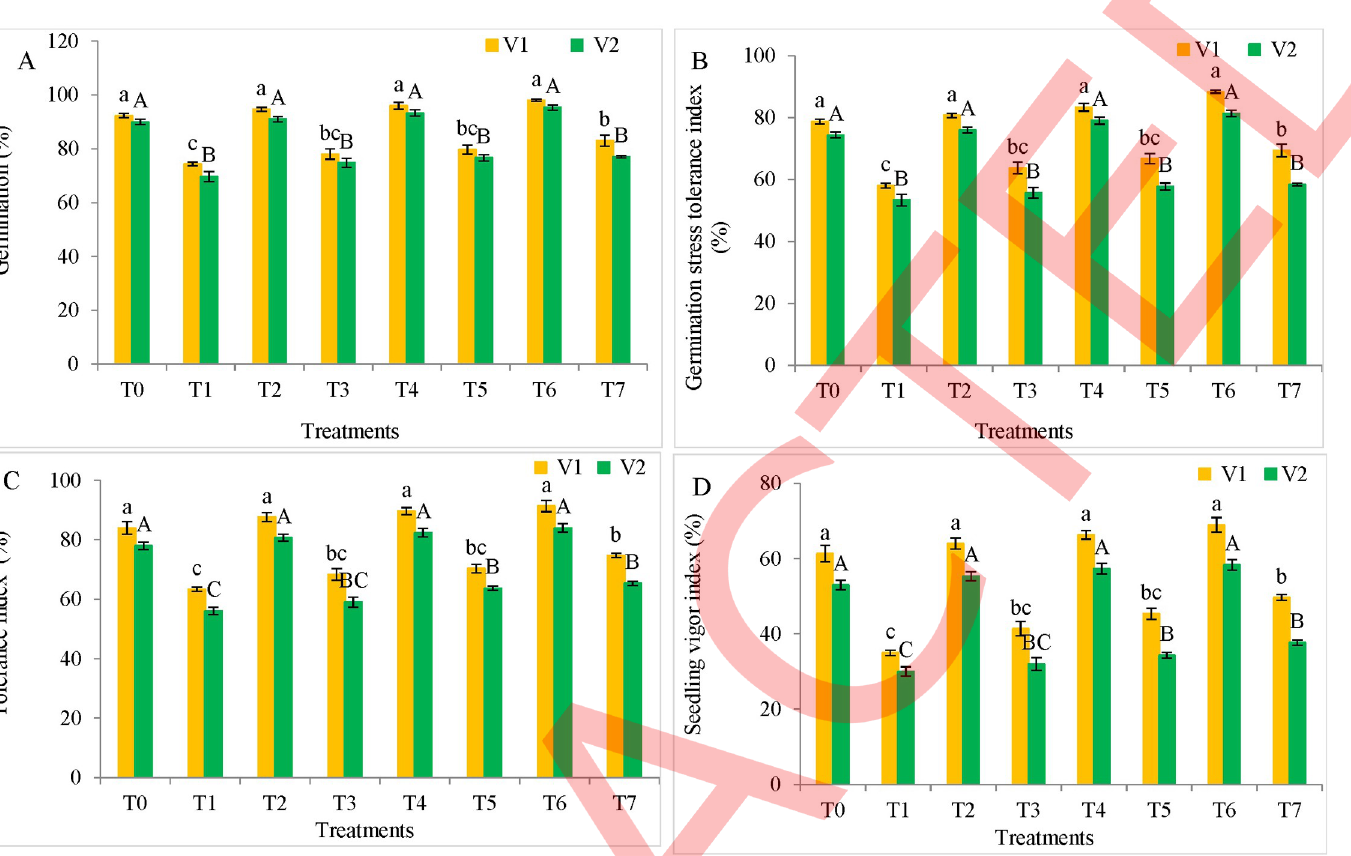
Fig 1. Effect of biochar and compost on germination attributes of Spinach under cadmium stress. (A) Germination percentage, (B) Germination Stress Tolerance Index, (C) Tolerance Index (D) Seedling Vigor Index of spinach. The mean of three replicates and standard deviation are presented. Different letters show significant difference among treatments. Control (T0), 10 ppm CdCl 2 (T1), biochar 1% (T2), biochar 1% + 10 ppm CdCl 2 (T3), compost 1% (T4), compost 1% + 10 ppm CdCl 2 (T5), compost 1% + biochar 1% (T6), compost 1% + biochar 1% + 10 ppm CdCl 2 (T7) .